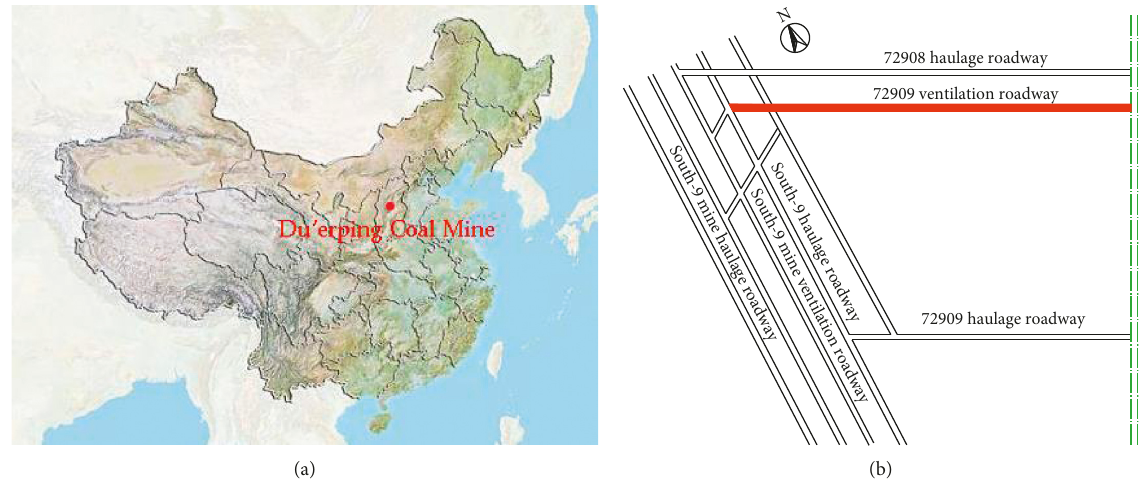
Figure 2: Location of (a) Du’erping coal mine and (b) the 72909 ventilation roadway.